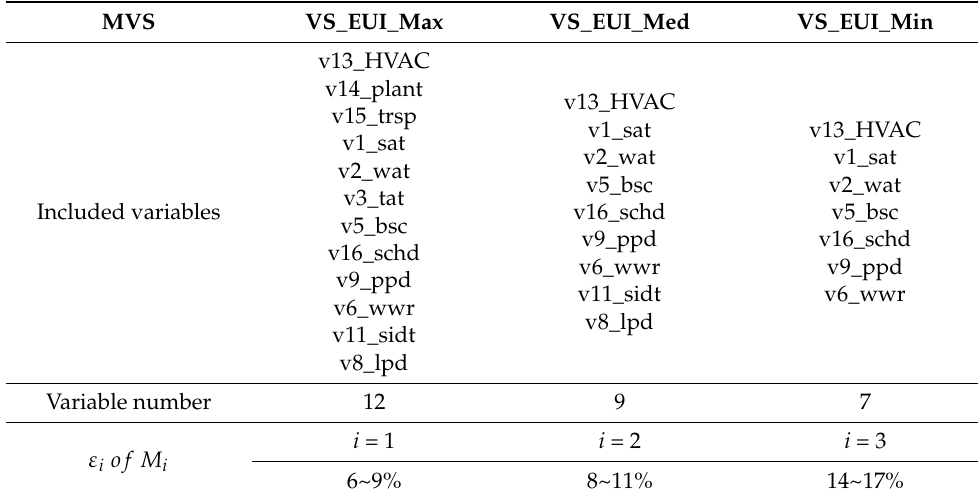
Table 3. Minimum variable sets for annual EUI